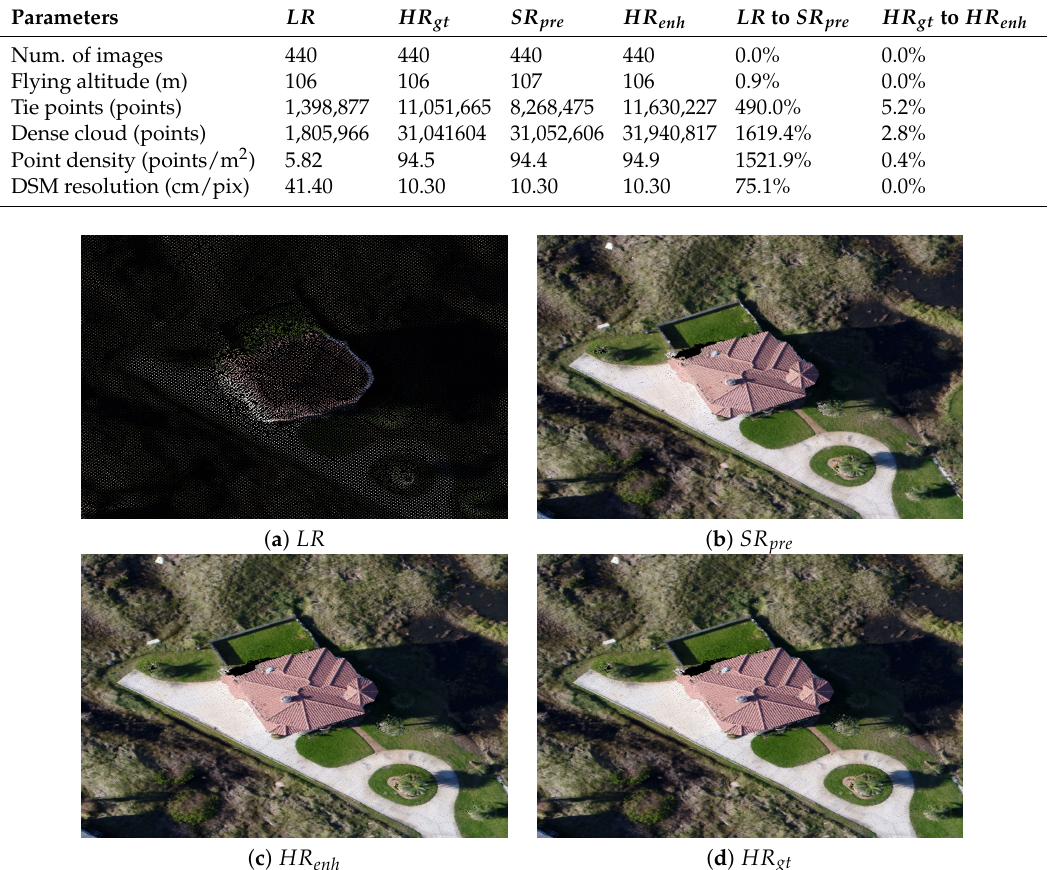
Figure 12. Resulting dense RGB point cloud computed within the SfM photogrammetry process using different image